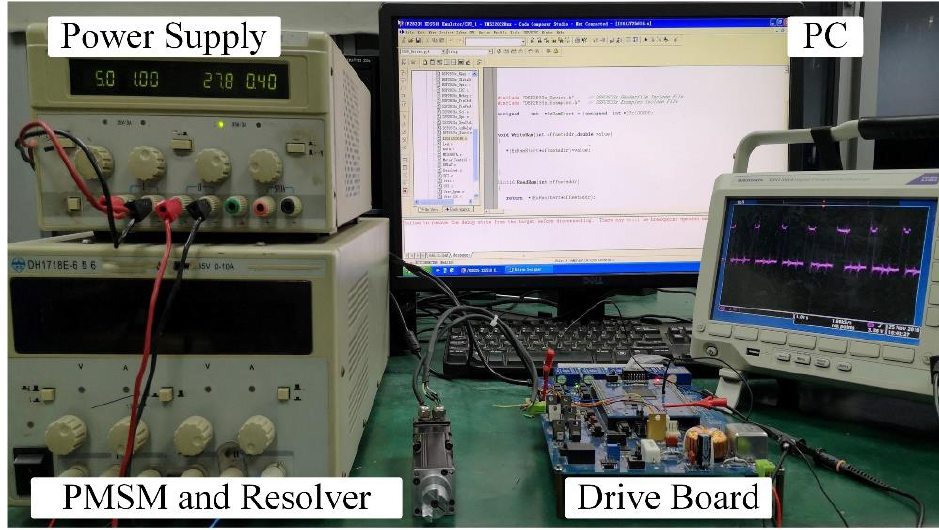
Figure 11. Experimental platform.